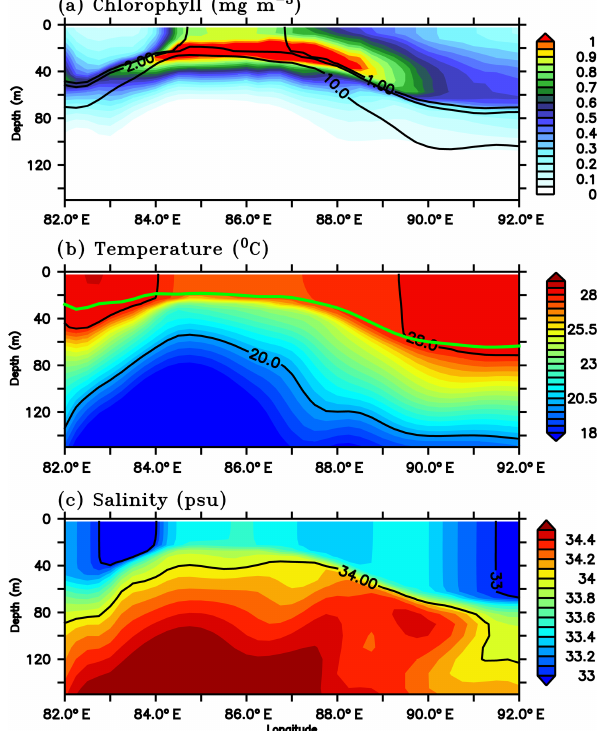
Figure 13. Depth–longitude sections of (a) chlorophyll (mgm − 3 ), (b) temperature ( ◦ C) and (c) salinity (psu) along 8 ◦ N for 1 July 2016 from the ecosystem model. Black contours in pan- els (a) , (b) and (c) represent nitrate (1, 2 and 10µmolkg − 1 ), tem- perature (20 and 28 ◦ C) and salinity (33 and 34psu) respectively. Green curve in panel (b) represents the model mixed layer